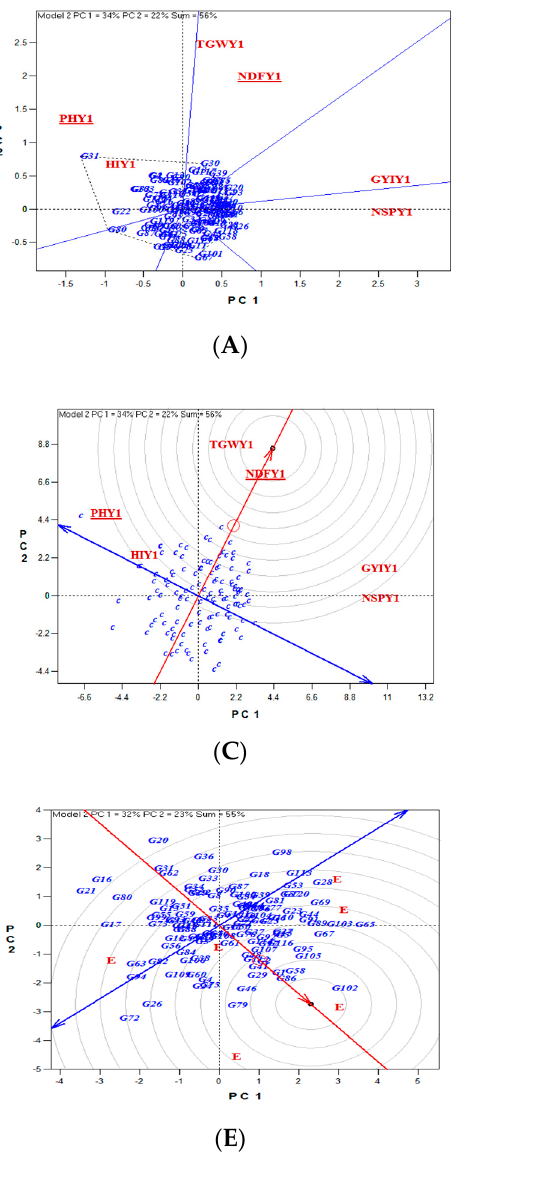
Figure 5. The reaction of lines caused Gonbad × Zagros crosses by considering significant traits in 2020 and 2022 using Biplot. Identifying genotypes with higher values for traits ( A , D ), determining the best genotype considering significant traits ( B , E ), and identifying the most important traits affecting genetic diversity ( C , F ).